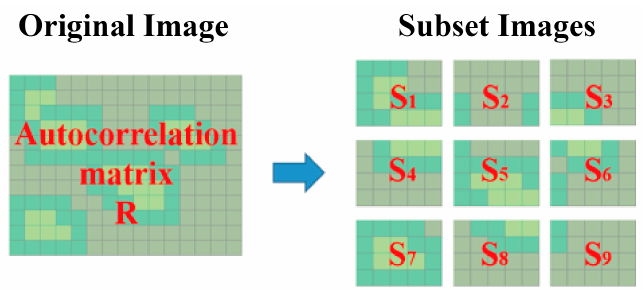
Figure 1. Schematic diagram for the autocorrelation matrix of the original image and subset images.